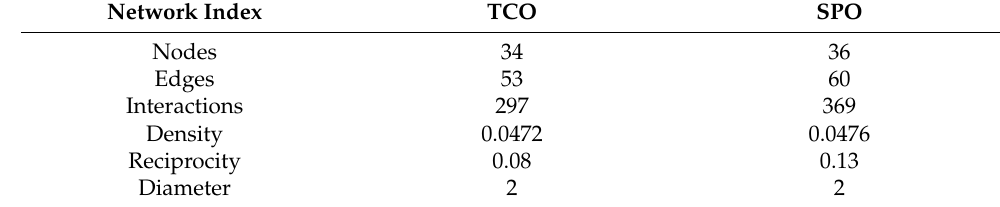
Table 3. Network-level metrics of TCO and SPO network models.